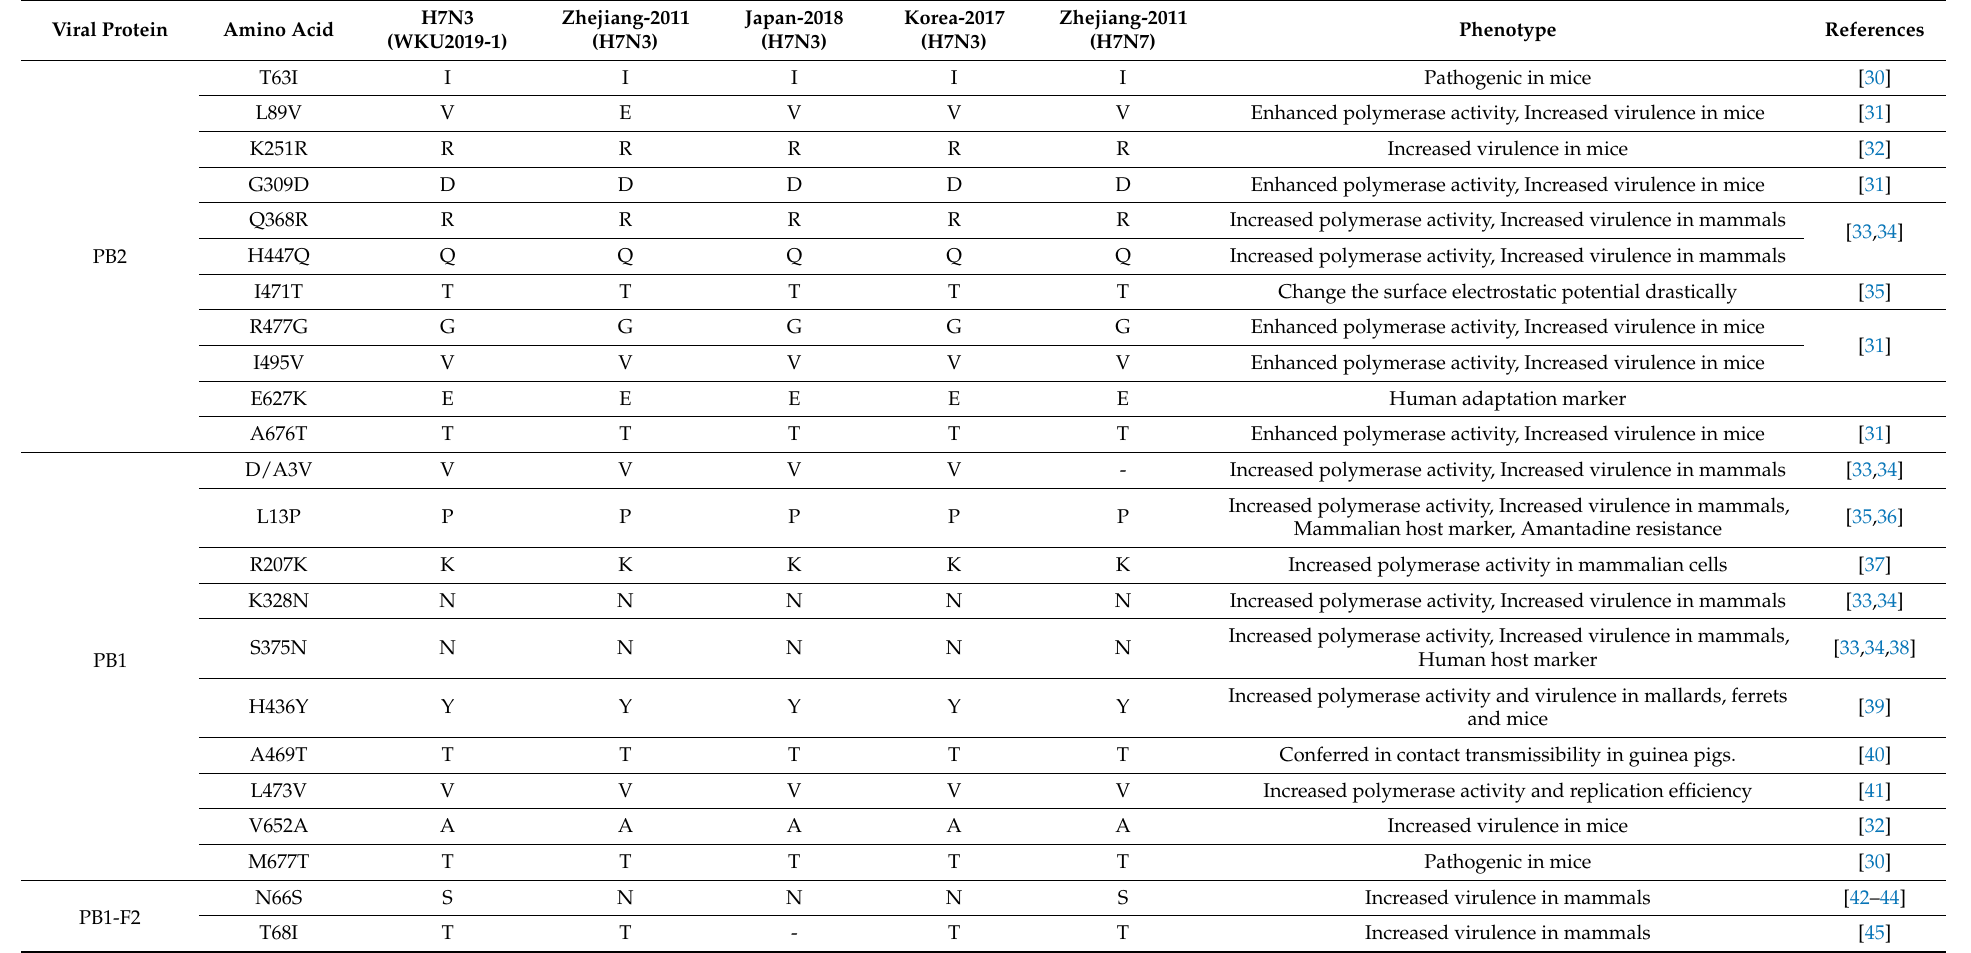
Table 3. Summary of data obtained from the mutational analysis of eight genes from AIVs of multiple avian species with the H7N3 (WKU2019-1) isolate. (“-”—no amino acid were found). Viral